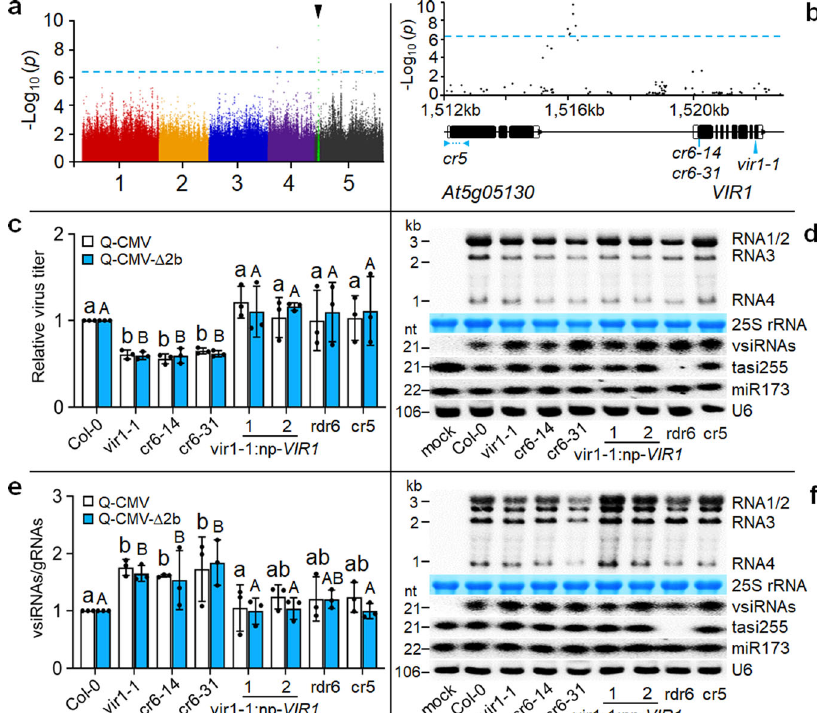
Fig. 3 Identi fi cation of VIR1 . a Manhattan plot for GWAS mapping of the susceptibility phenotype to Q-CMV infection. The horizontal dash-dot line corresponds to the signi fi cance threshold ( p = 5.45 × 10 − 7 ). The black tringle above the threshold indicates the most signi fi cantly associated locus. b Regional Manhattan plot (from 1512 kb to 1522 kb), structure of VIR1 , and positions of T-DNA insertion allele vir1-1 and CRISPR/Cas9 genome edited alleles ( cr5 in At5g05130 and cr6-14 and cr6-31 in VIR1 ). c , d , f , Accumulation of Q-CMV ( c , d ) or Q-CMV- Δ 2b ( c , f ) detected in wild-type (Col-0), cr5 mutant, vir1 mutants ( vir1-1 , cr6-14 and cr6-31 ), or two independent VIR1 -complemented lines of vir1-1 at 2 weeks post-infection by RT-qPCR analysis of the viral RNA3 ( c ) or Northern blotting of the viral RNAs 1-4 ( d , f ). The vsiRNAs and plant endogenous small RNAs were also detected by Northern blotting ( d , f ). e The vsiRNAs/gRNAs ratios were calculated as described in the legend to Fig. 1. Data in ( c ) and ( e ) are means ± SEM from three independent experiments, letters indicate groups with signi fi cant differences (one-way ANOVA, Duncan, p < 0.05) and black dots represent the individual values. The source data underlying blots in ( d ) and ( f ), qRT-PCR data in ( c ) and ratio data in ( e ) are provided as a Source Data fi